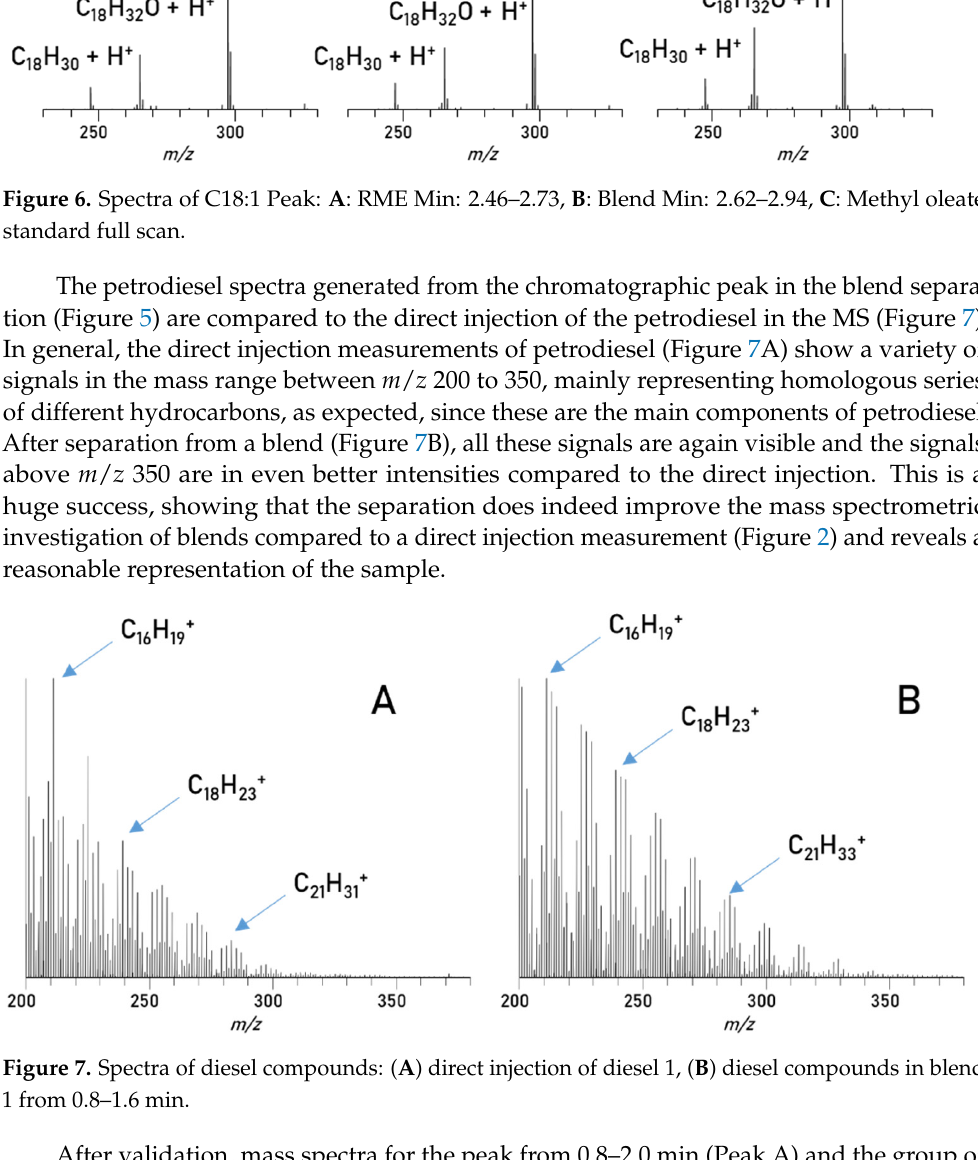
Figure 5. Chromatogram of the blend separated and measured with Method 1.